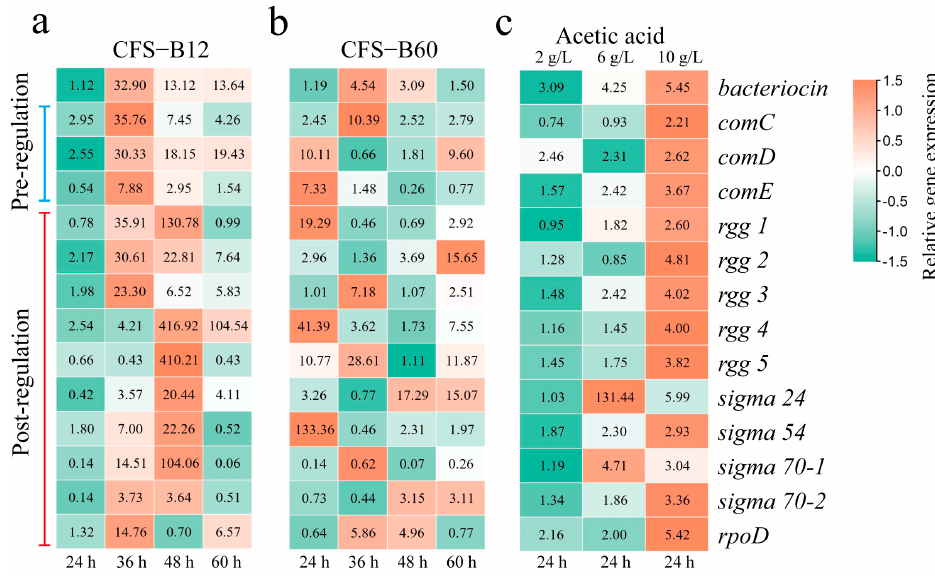
Figure 2. Effects of CFS and acetic acid on gene expression of the bacteriocin regulatory system. The numbers in the boxes indicate the relative expression levels of the genes. The relative expression levels of genes were normalized at the time level. Data normalization results are scaled with the legend.